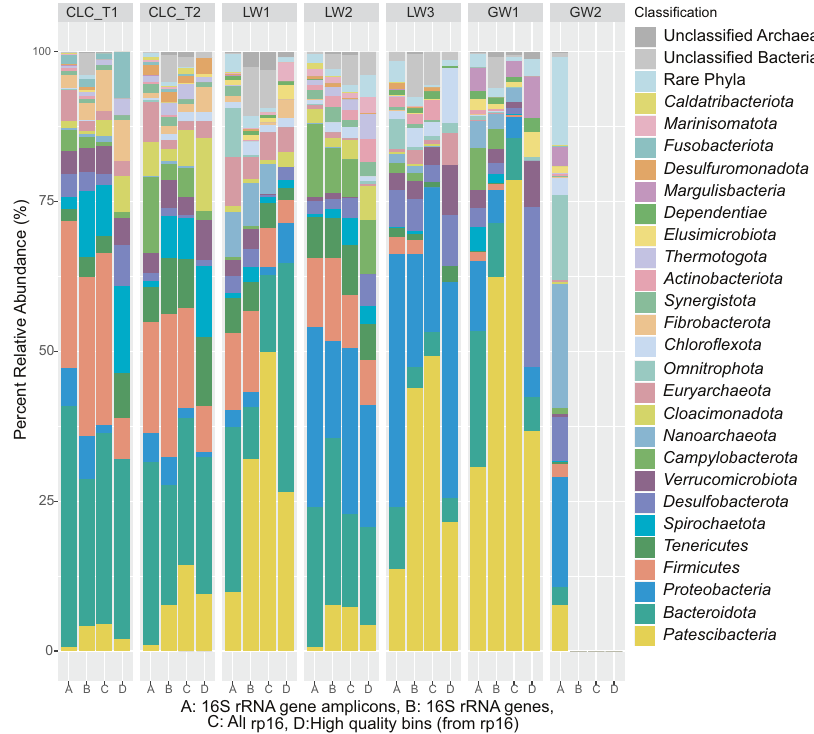
Fig. 2 Relative abundances for phyla present at greater than 1% abundance in at least one sample. A ) 16 S rRNA gene amplicons; B ) 16 S rRNA genes derived from the assembled metagenomes; C ) concatenation of 16 syntenic ribosomal proteins derived from the assembled metagenomes, with scaffold coverage as a proxy for abundance; and D ) high quality bins (containing the 16 concatenated ribosomal proteins, and with abundances calculated from the ribosomal protein-encoding scaffolds ’ coverages). The Composite Leachate Cistern at timepoint 1 (CLC_T1) is represented by the 0.2 µm fi lter ’ s sequence information, as the 0.1 µm fi lter showed highly similar results. Site GW2, the unimpacted groundwater well, did not yield suf fi cient biomass for metagenomic sequencing, thus only 16 S rRNA gene amplicons are reported